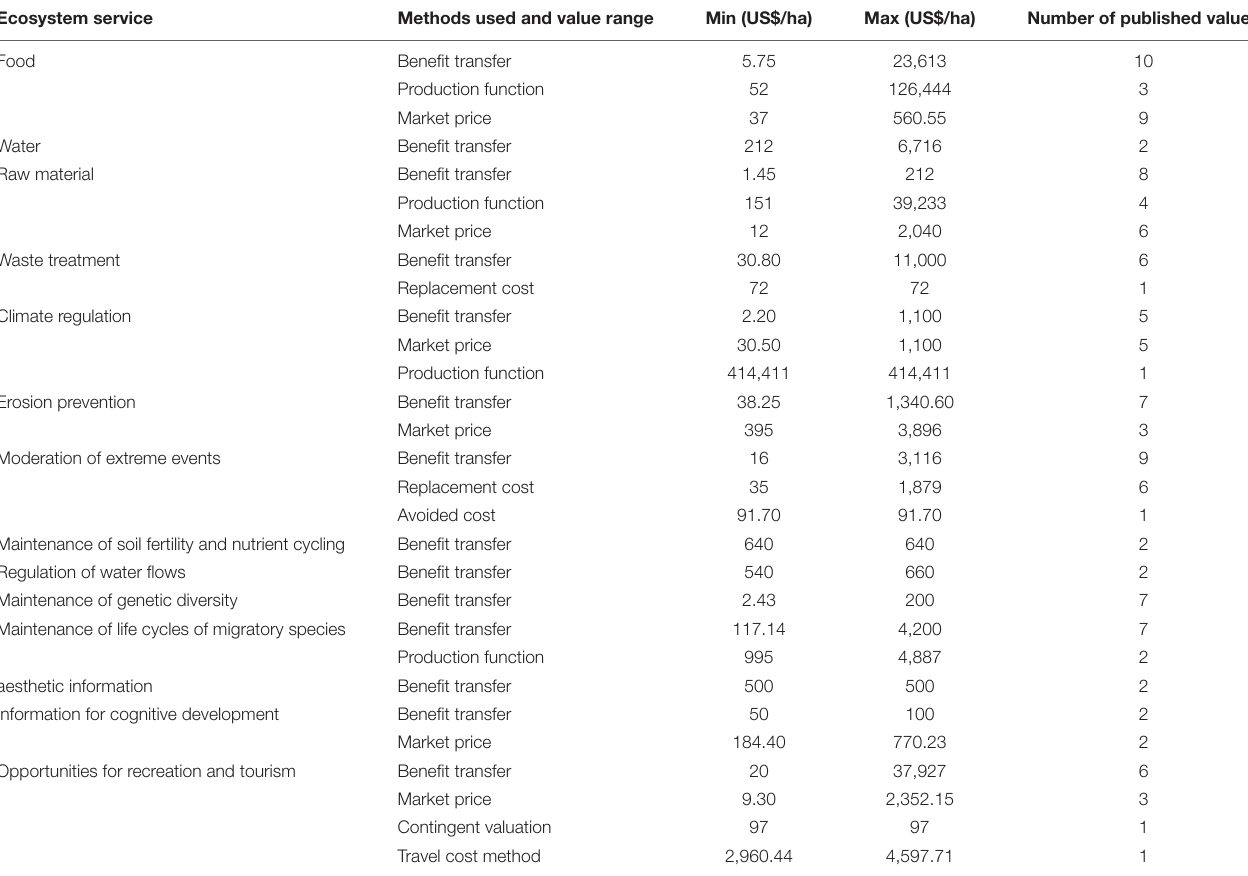
TABLE 6 | Use of valuation methods and range values in United State dollars per ha for ecosystem services provided by mangroves as reported by studies published between 2007 and 2016. Ecosystem service Methods used and value